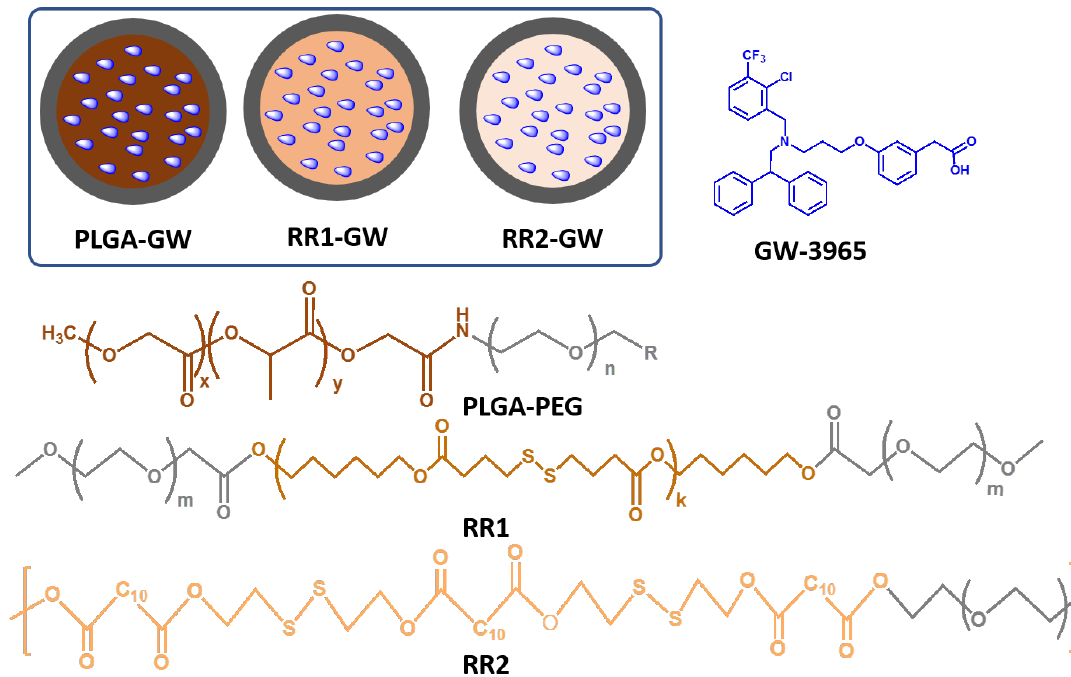
Figure 1. Schematic diagram of nanoparticles used in this study (inset), and chemical structures of polymers (R = COOH) and GW-3965.